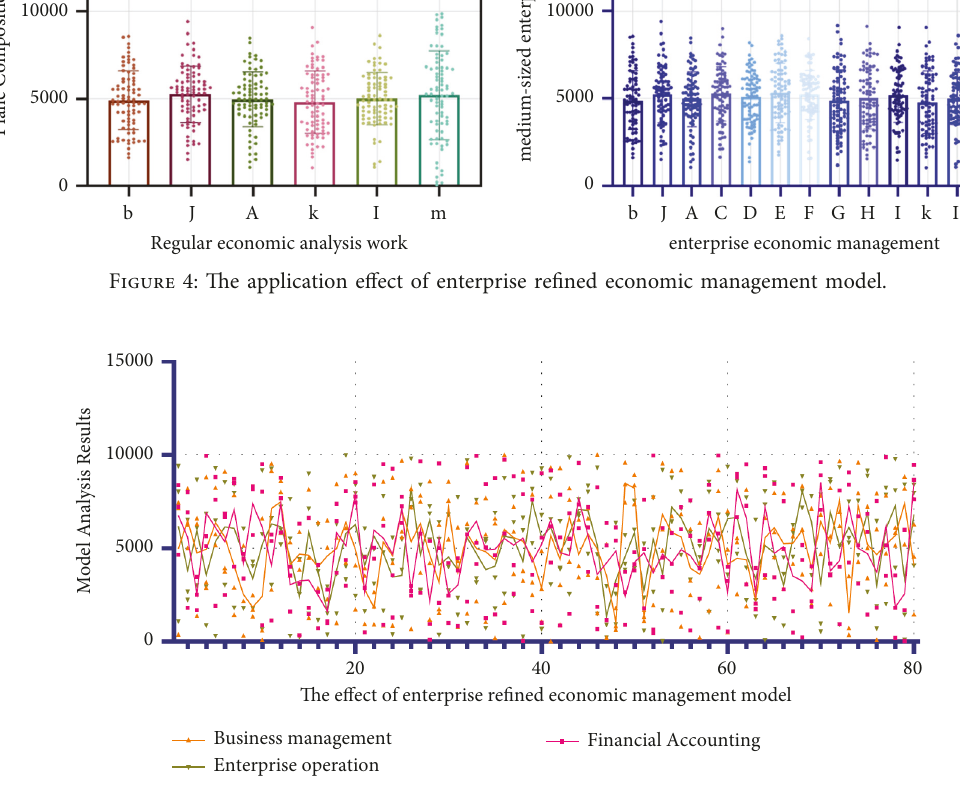
Figure 5: The application effect of enterprise refined economic management model.